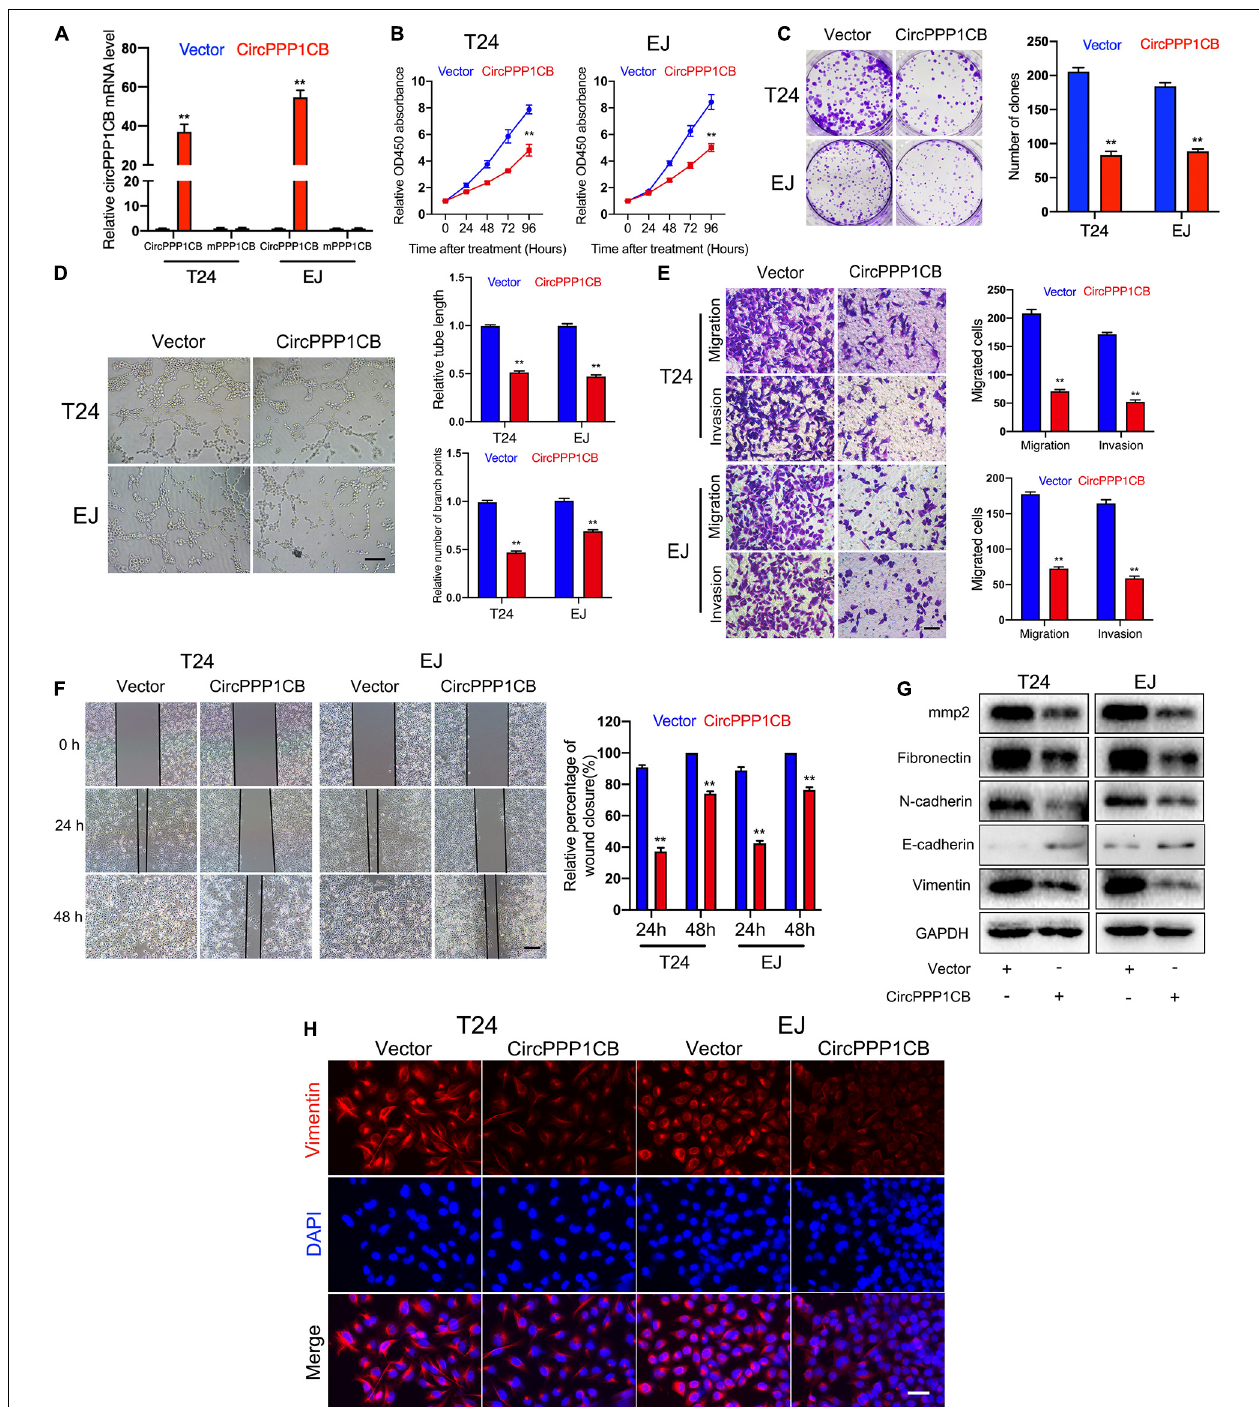
FIGURE 2 | CircPPP1CB inhibits proliferation, angiogenesis, migration, and invasion of bladder cancer cells. (A) CircPPP1CB was significantly upregulated in circPPP1CB-overexpressing T24 and EJ cells. (B) CCK-8 assays indicated that CircPPP1CB reduced cell proliferation rate in bladder cancer cells. (C) Colony formation was evaluated by colony formation assay in negative control or circPPPC1B-overexpressing cells. (D) Tube formation assay was conducted in HUVECs with different conditional medium. Scale bars, 400 µ m. (E,F) Transwell migration, invasion assay, and cell scratch assay indicated the biological effects of circPPP1CB in T24 and EJ cells. Scale bars, 200 and 400 µ m, respectively. (G) EMT markers (fibronectin, N-cadherin, E-cadherin, and vimentin) and MMP2 were detected by western blotting in different T24 and EJ cells. (H) Immunofluorescence analysis of vimentin in circPPP1CB-overexpressing cells and negative control cells. Scale bars, 200 µ m. ** p < 0.01 vs. control